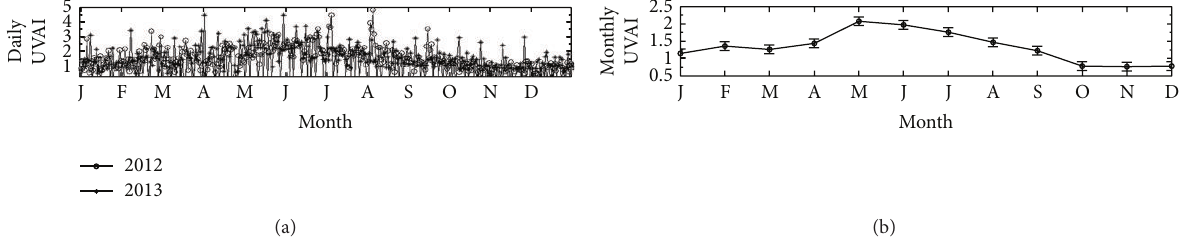
Figure 4: (a) The monthly climatology means of UVAI over region 3 (EP) for 2012-2013 and (b) is Daily OMI UVAI for 2012-2013. The vertical bars represent standard